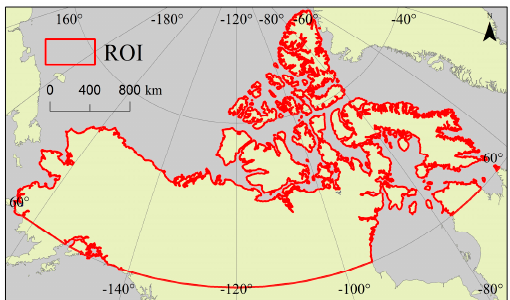
Figure 2. The areas considered within this study (the Arctic and Boreal regions above 60° N in northern North America).